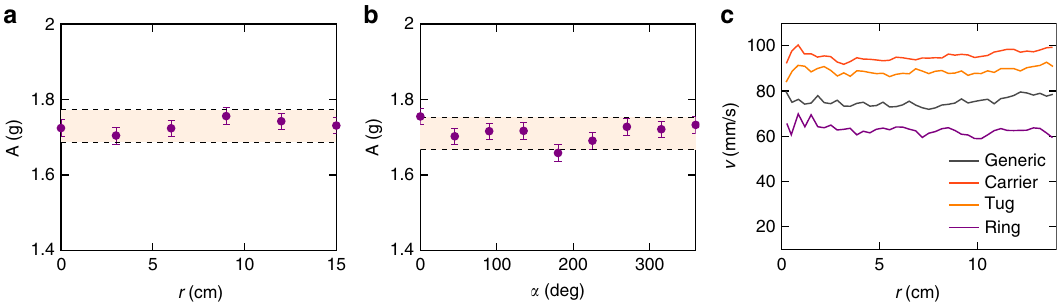
Fig. 7 Spatial variation of excitation amplitude and particle velocity. Excitation amplitude in dependence of a radial positions at a fi xed azimuthal angle ( α = 0) and b azimuthal angle at fi xed radial position ( r = 6 cm). The shaded area illustrates a width of ±2.5% around the mean. Error bars illustrate the sensorial accuracy (s.e.m.). c Average velocity of particles as a function of the radial position for all